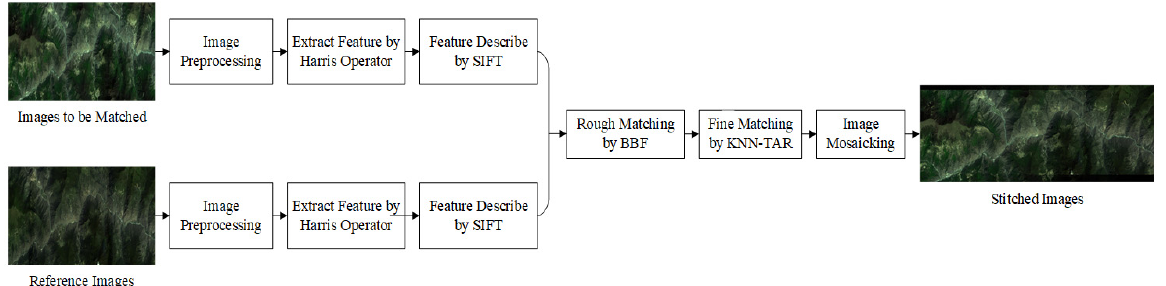
Figure 1. The proposed image registration algorithm flow chart.